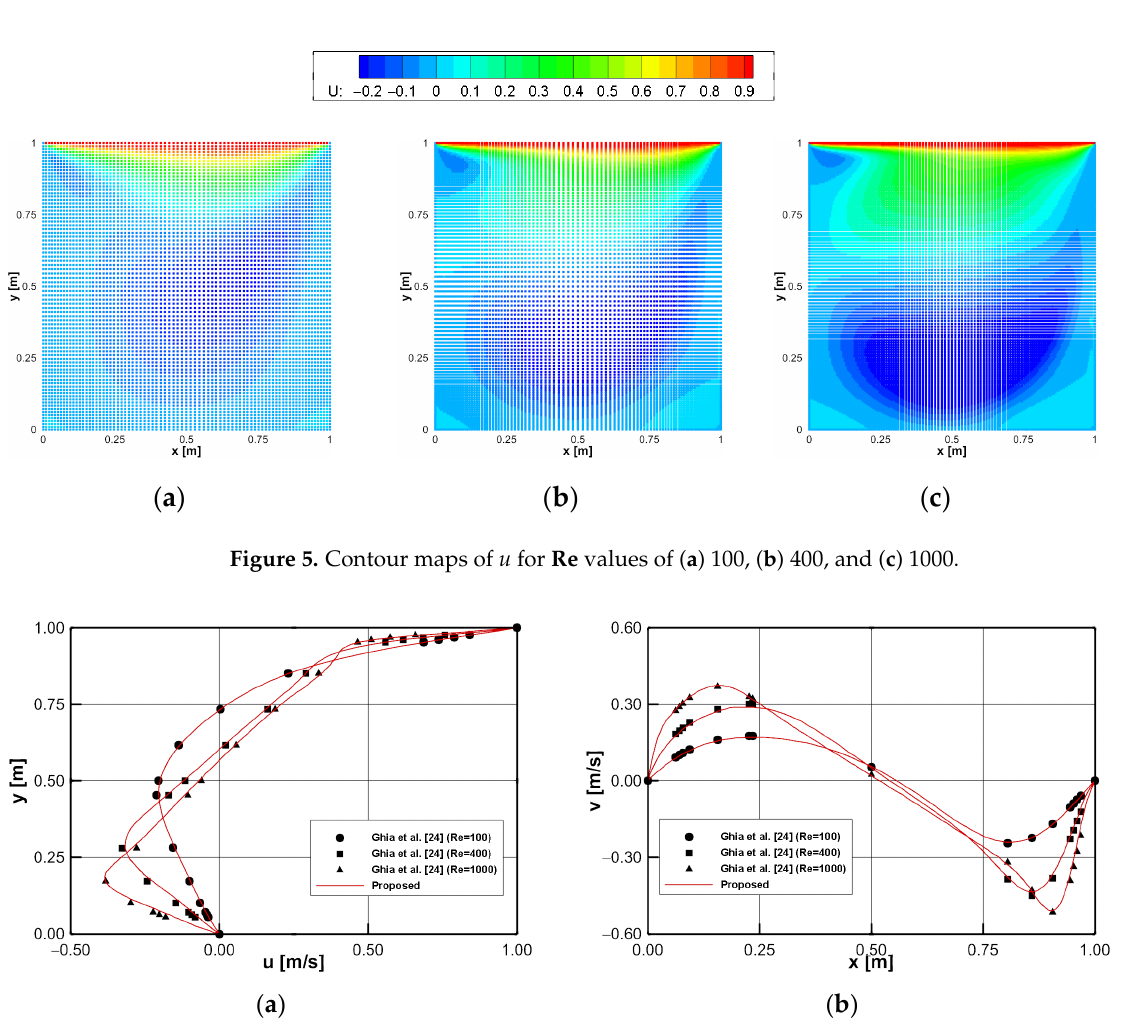
Figure 6. Comparison of velocity profiles ( a ) u and ( b ) v along the vertical and horizontal center planes for different Reynolds numbers. Table 1. Comparison of computational time (Cavity flow, Re =